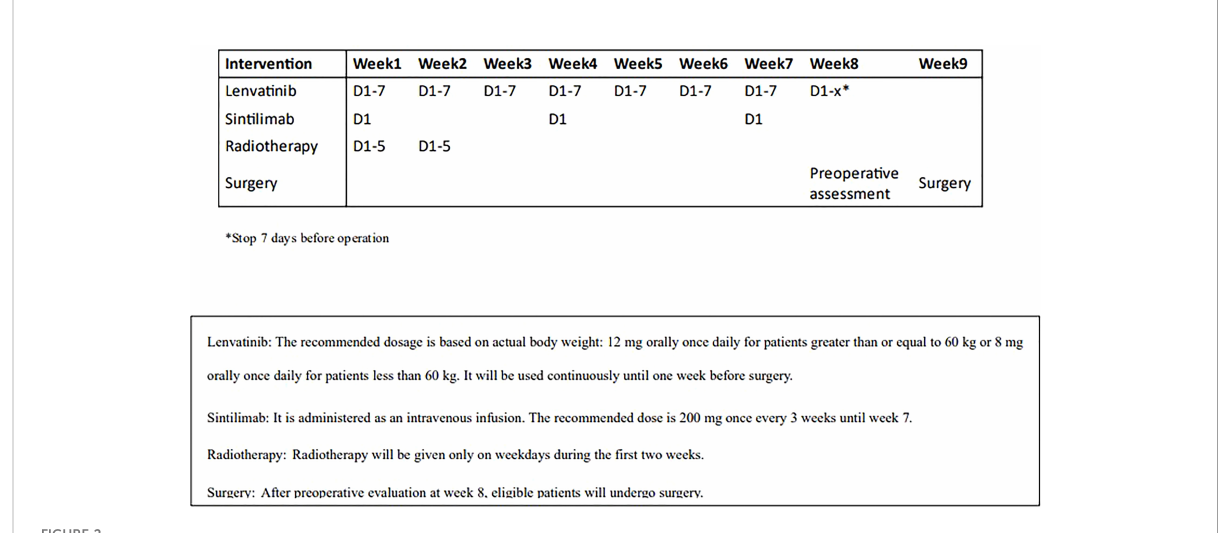
FIGURE 2 Clinical trial